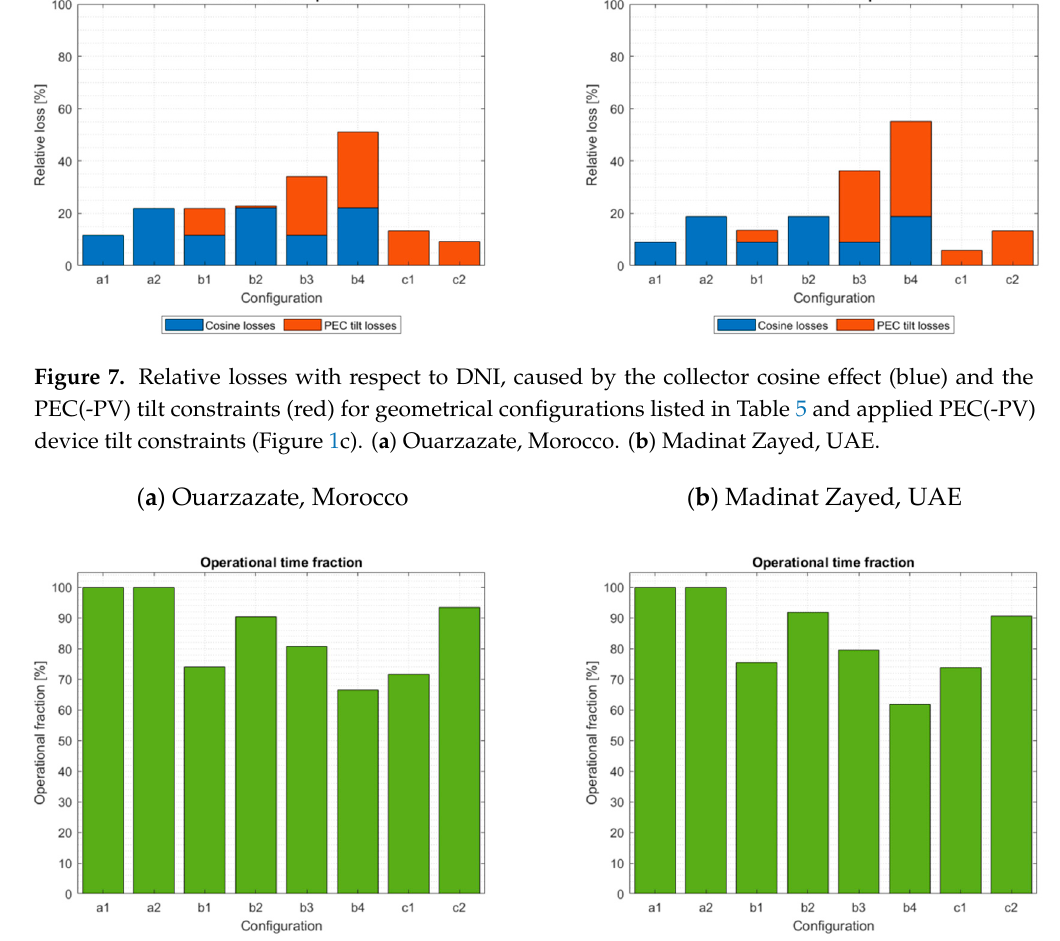
Figure 8. Operation time fraction and its reduction due to PEC(-PV) device tilt constraints (Figure 1c) for geometrical configurations listed in Table 5. A ratio of 100% corresponds to a configuration operational from sunrise to sunset. ( a ) Ouarzazate, Morocco. ( b ) Madinat Zayed, UAE.